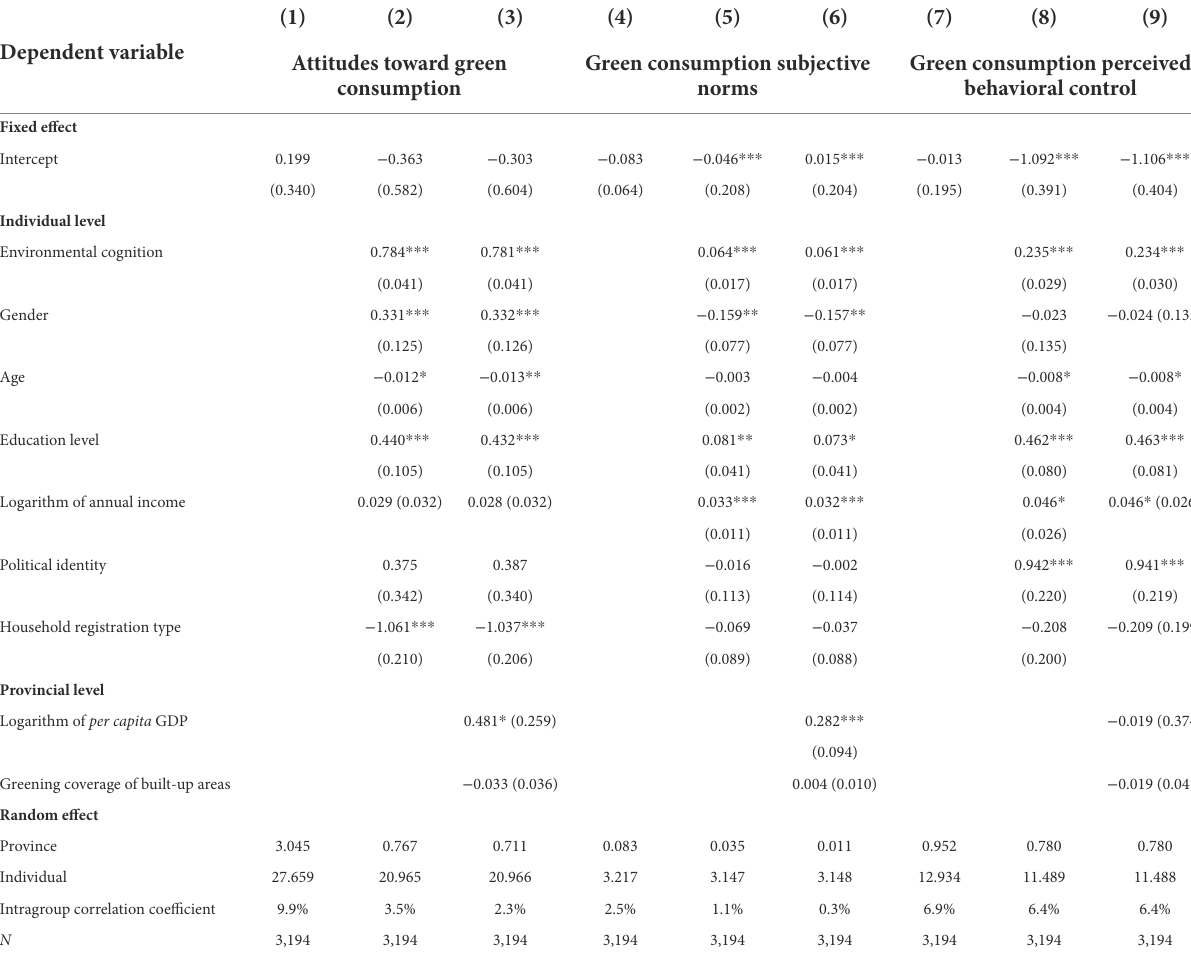
TABLE 3 Results of the multilayer linear model of the impact mechanism of green consumption based on the TPB (I).